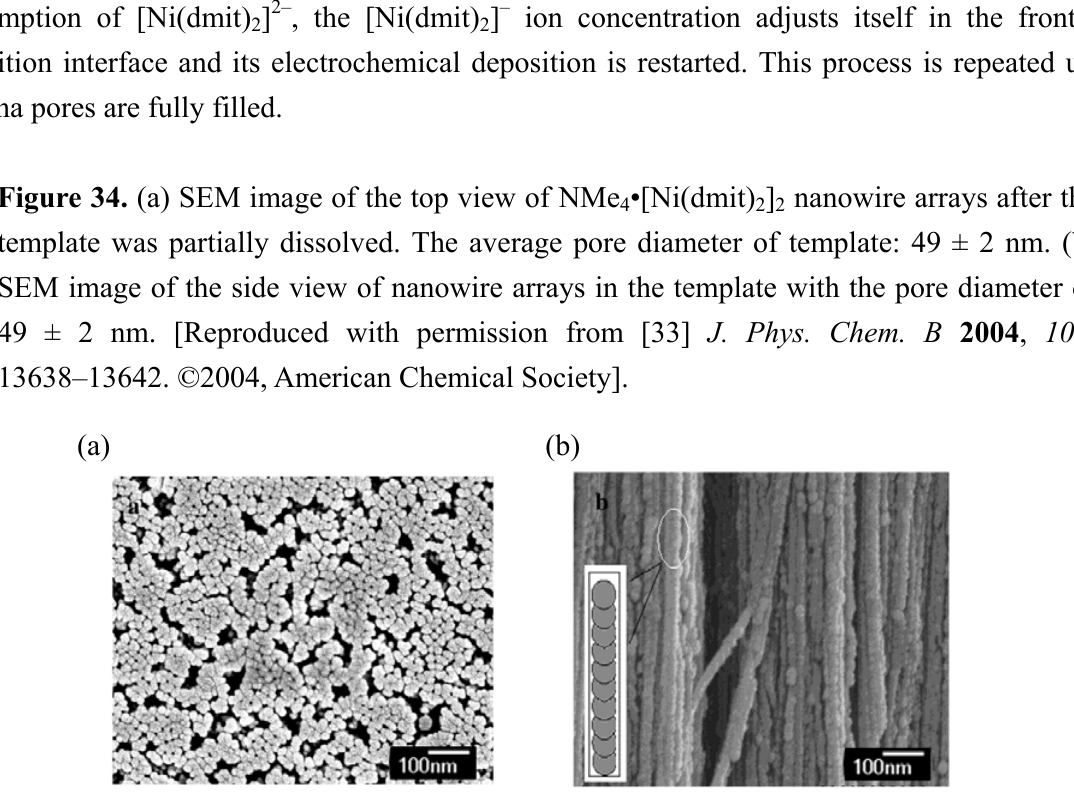
Figure 34. (a) SEM image of the top view of NMe